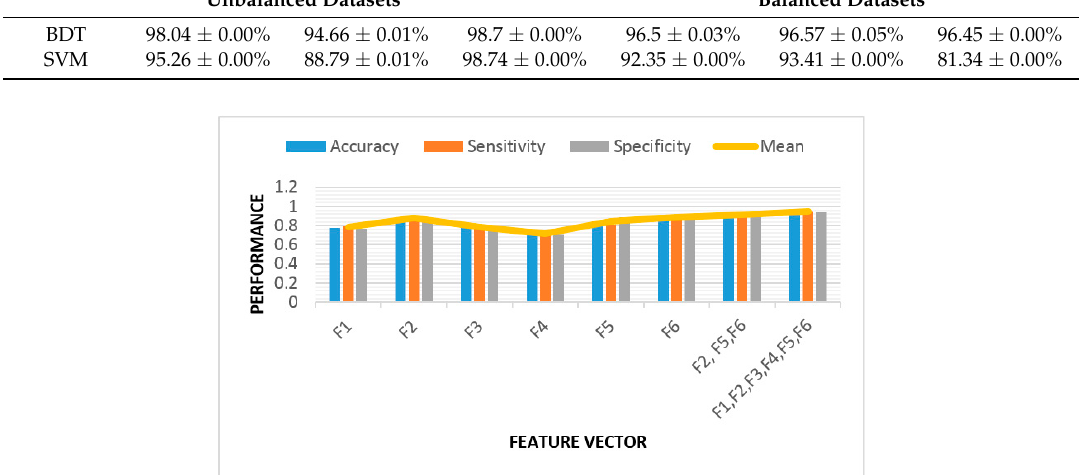
Figure 12. Feature validation for VF detection algorithm based on the balanced binary decision tree (BDT) classifier. The mean is the average of accuracy, sensitivity, and specificity values for each of the feature vectors.